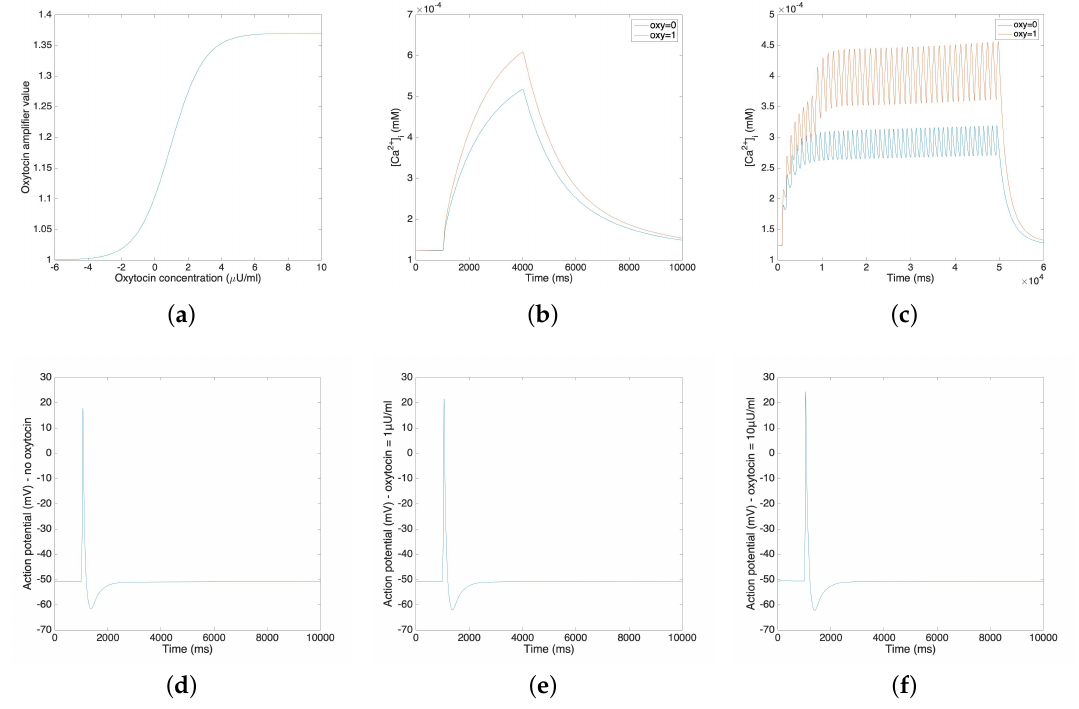
Figure 3. ( a ) Oxytocin amplifier value with respect to the concentration of oxytocin. ( b ) Change of calcium concentration of plateau type action potential under the application of 1 µU/mL